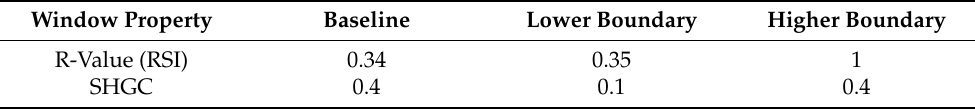
Table 2. Upper and lower boundaries for R-value and SHGC applied in GA optimization. Window